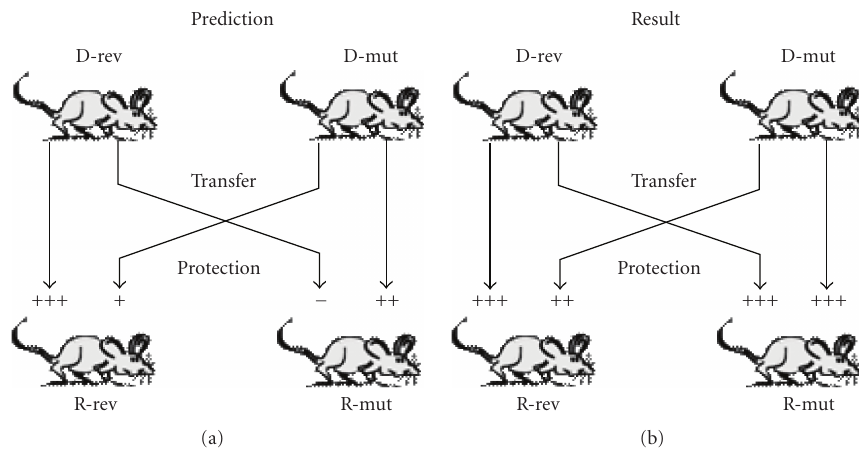
Figure 5: Sketch of a criss-cross adoptive CD8 T-cell transfer experiment for evaluating the role of viral epitope mismatch in protection against CMV disease by cellular immunotherapy. (a) Predicted result. (b) Actual result. Memory CD8 T-cell donors D-rev and D-mut were immunocompetent BALB/c mice infected 6 months earlier with mCMV-rev and mCMV-mut, respectively, expressing or lacking two immunodominant epitopes (IE1 and m164). Recipients R-rev and R-mut were immunocompromised BALB/c mice acutely infected with the respective viruses shortly after the cell transfer. Arrows indicate the direction of cell transfer. The predicted and observed e ffi cacies of antiviral protection are qualitatively classified from very e ffi cient (+++) to ine ffi cient (). Experimental assessment of antiviral protection was performed by measuring virus replication in spleen, lungs, and liver. For experimental details and the original quantitative data, see